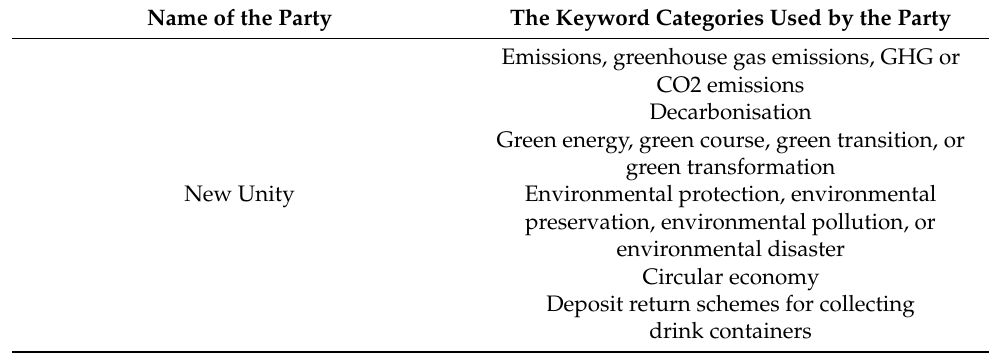
Table 8. Keyword categories identified in each party’s